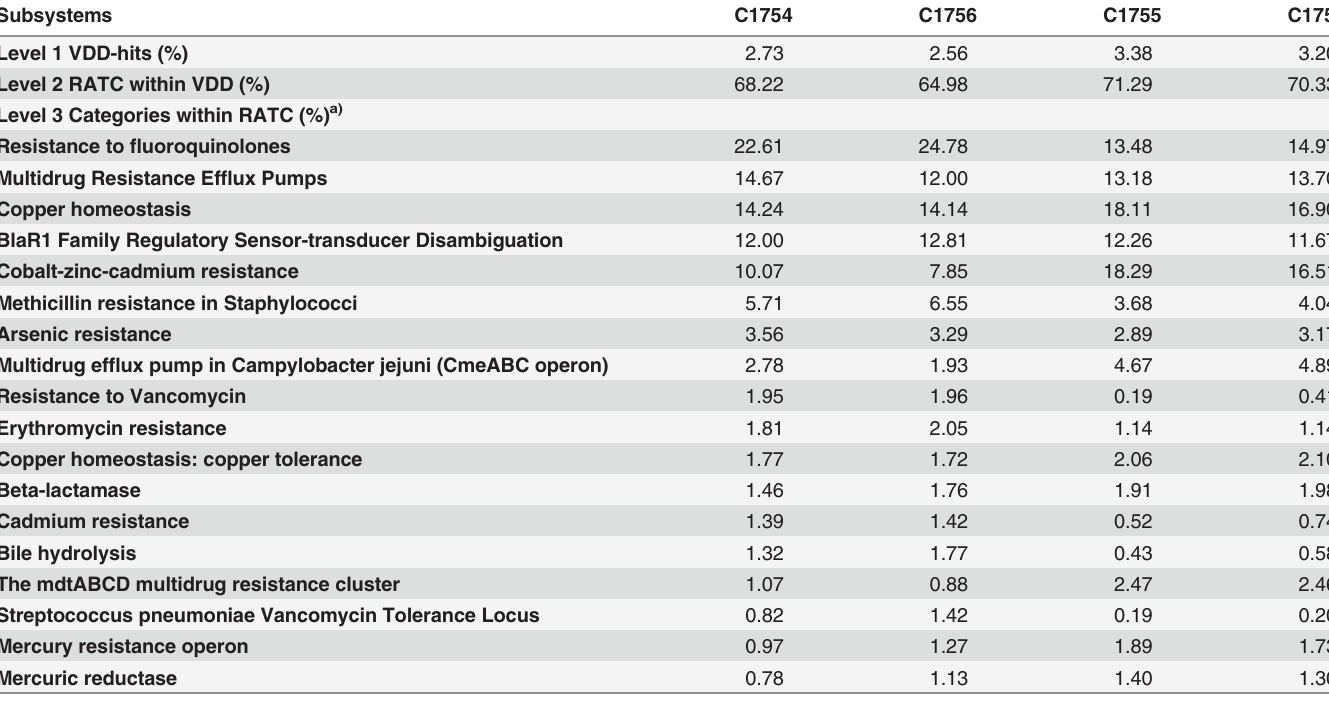
Table 2. Relative abundance of VDD and RATC genes ( (cid:3) 1%) in the